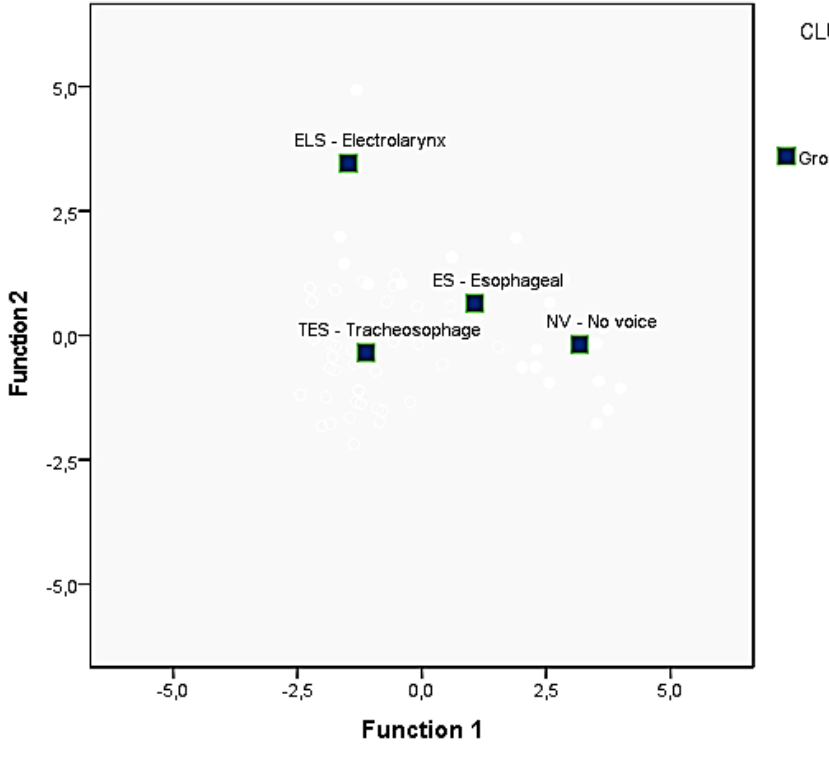
Figure 6. Plot of centroids of the